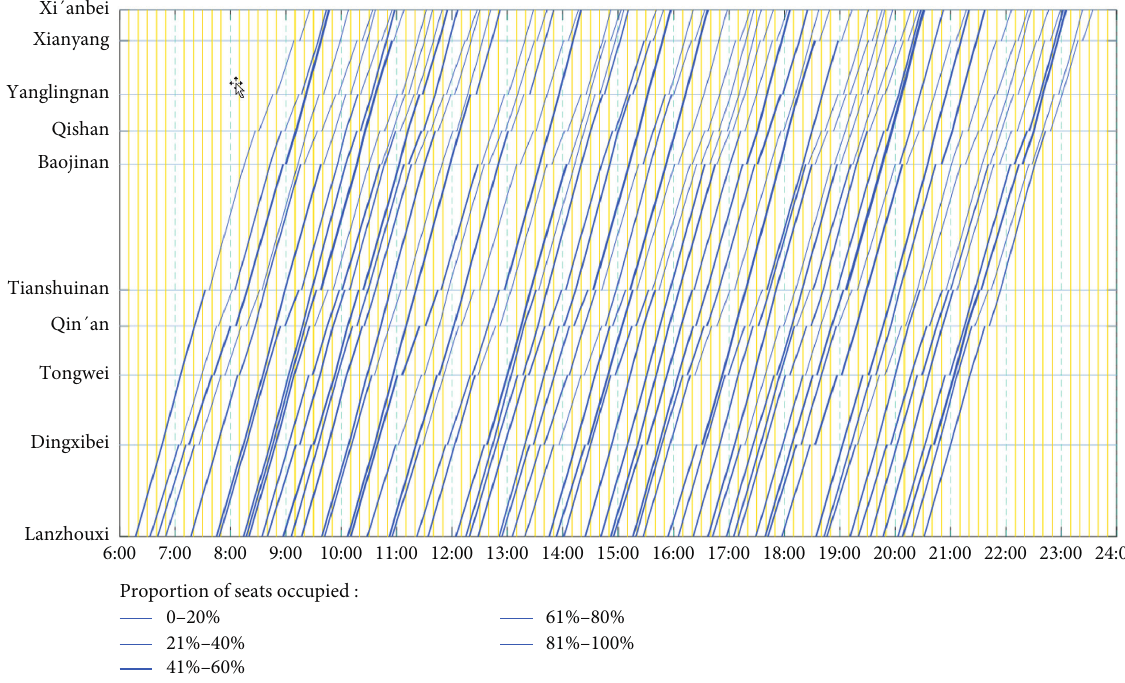
Figure 17: Train diagram with seats occupancy information.